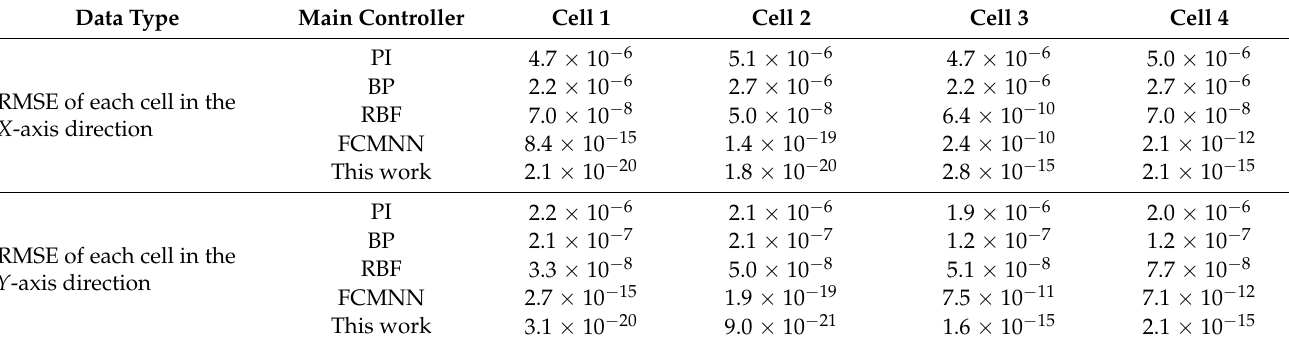
Table 4. RMSE of each controller.